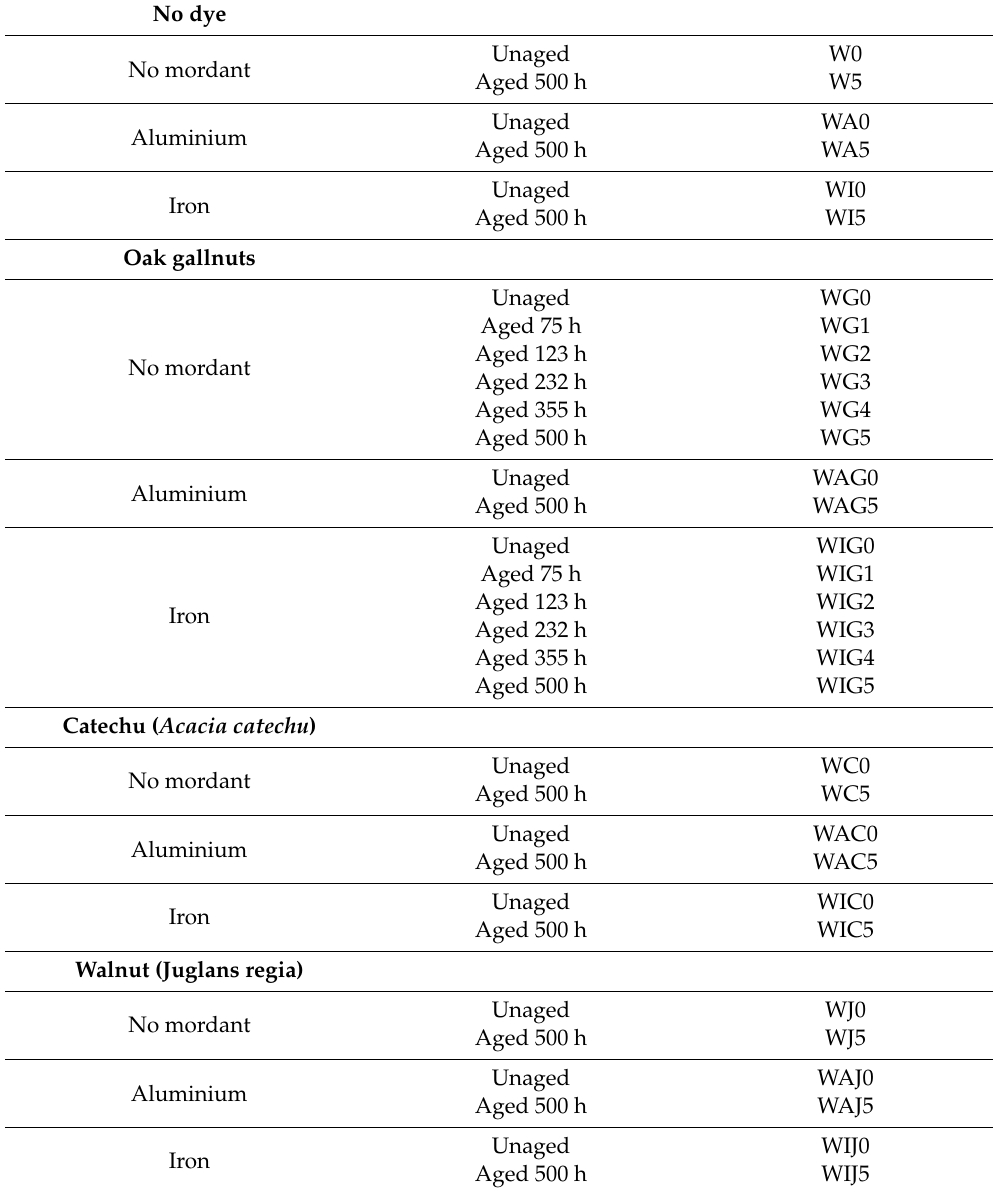
Table 3. List of all the analyzed samples. Labels for each sample are presented in the rightmost